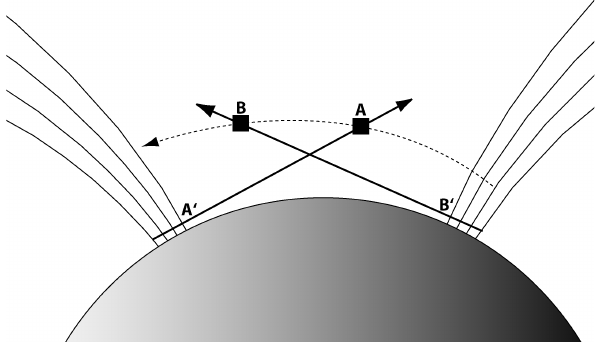
Fig. 14. Viewing geometry during a typical south polar perigee pass of TC-2.